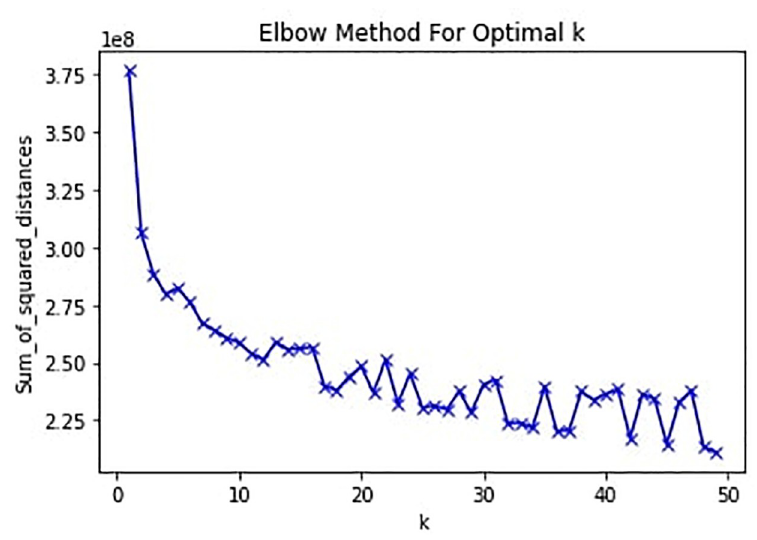
Fig 1. Elbow method for optimal